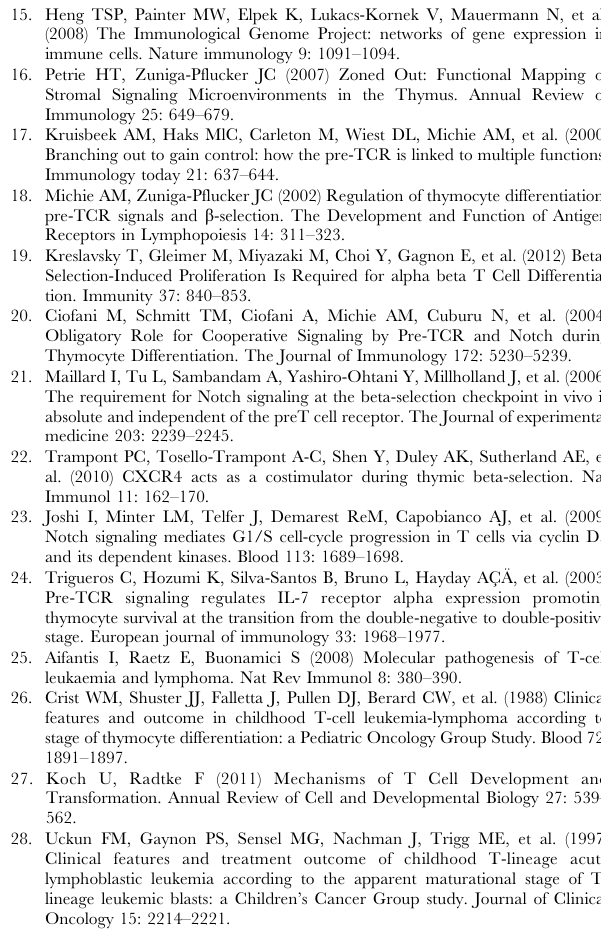
Figure S5 Peripheral compartment and activation of Shcbp1 + / + and Shcbp1 2 / 2 CD4 + T cells. (A) Surface staining, and (B) absolute numbers of CD4 + and CD8 + cells in spleen and lymph nodes of wild-type and Shcpb1 deficient mice (n . 3 mice per genotype). (C) Intracellular staining for Foxp3 in CD4 + T cells from Shcbp1 WT and deficient mice (n =2 mice per genotype). (D) Flow cytometry for cell surface markers (CD44, CD62L, CD25, and CD69, CD4) of CD4 + T cells isolated from Shcbp1 + / + and Shcbp1 2 / 2 mice after 24 hour stimulation with anti-CD3/anti- CD28 (n= 3 mice of each genotype).